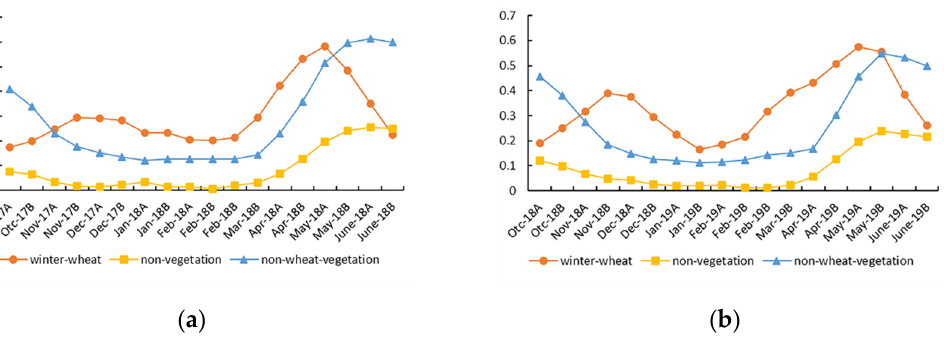
Figure 2. ( a ) NDVI time series curves of automatically extracted sample sites in Shijiazhuang in 2018. ( b ) NDVI time series curves of automatically extracted sample sites in Shijiazhuang in 2019.